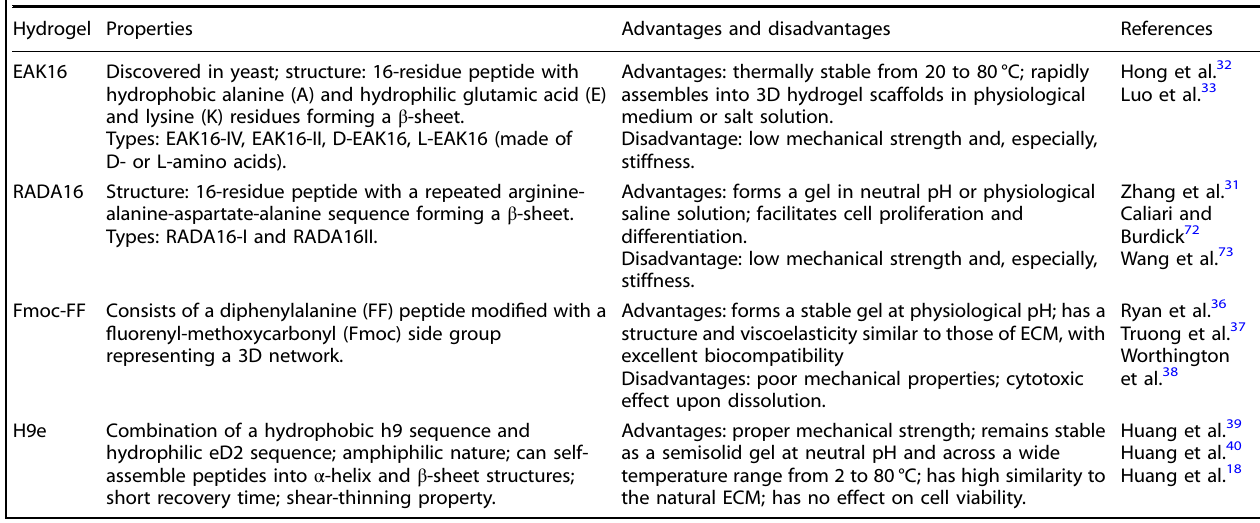
Table 1. Advantages and disadvantages of available peptide